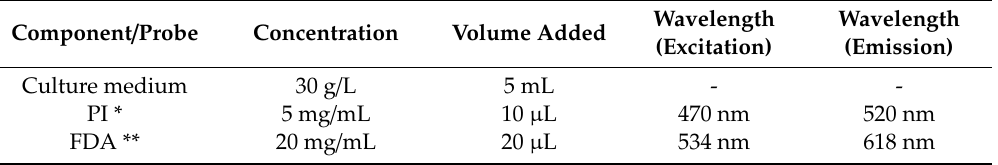
Table 1. Staining solution components and excitation / emission wave lengths for confocal microscopy. Component / Probe Concentration Volume